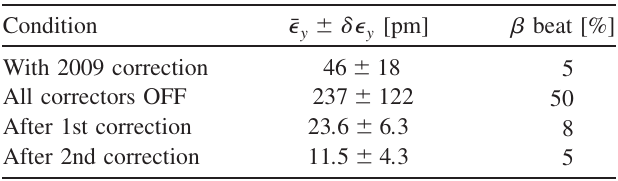
TABLE I. Summary table of the first correction with RDTs of January 16, 2010. The corresponding horizontal emittance is ’ E ’ E ’ 4 nm . Beta beat refers to the peak (cid:3) x x u